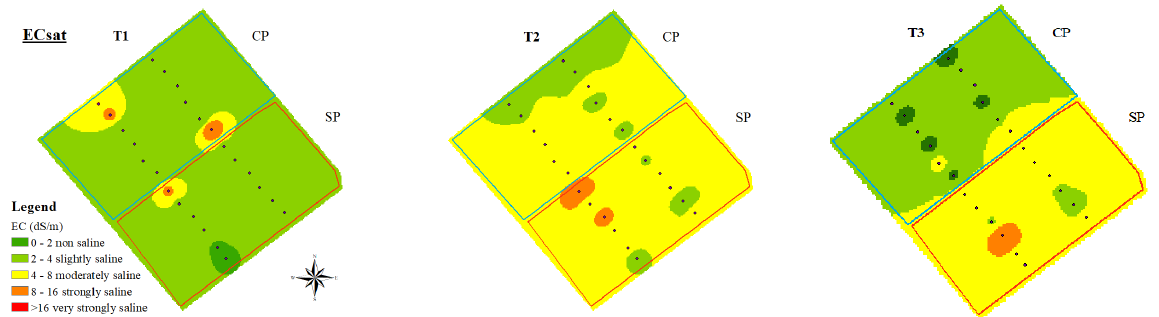
Figure 1. Maps of the electrical conductivity of the soil (ECsat) for the samples taken in the ridges (represented by black dots in the maps) in T1, T2, and T3.